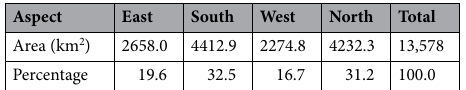
Table 2. Statistics for different aspect